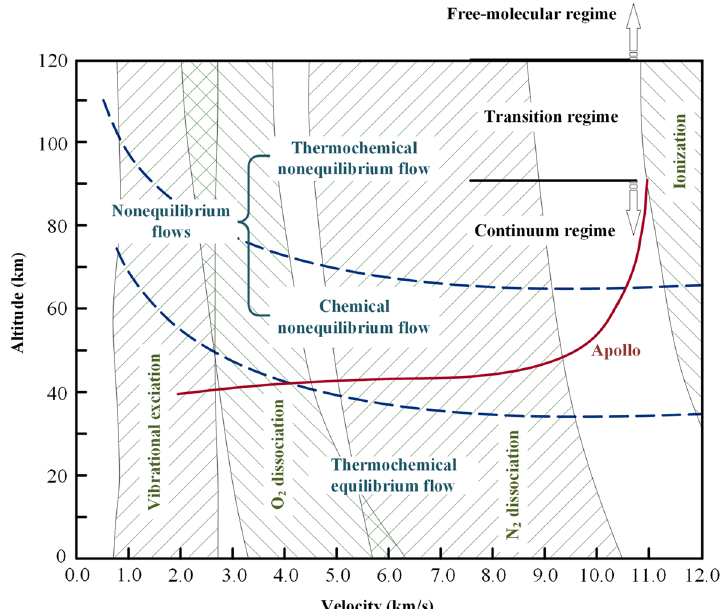
Fig. 2 Characteristics of hypersonic flows [17,